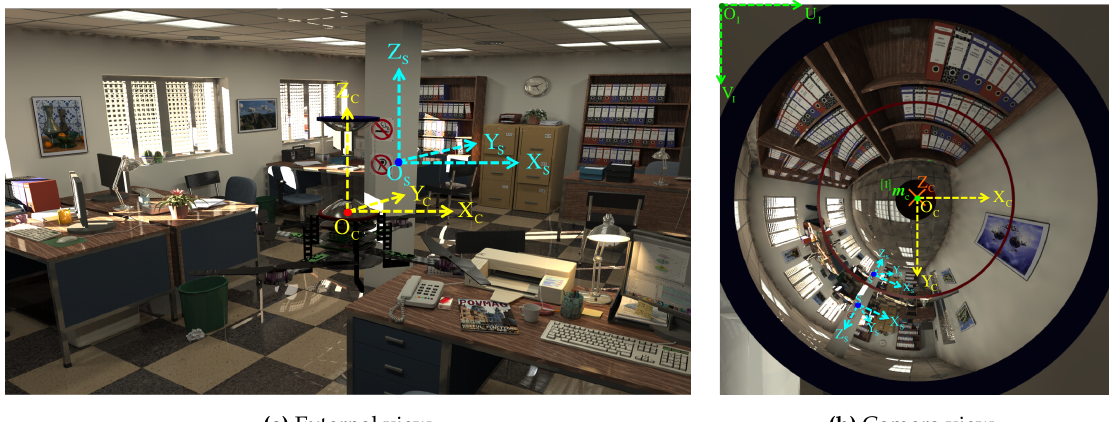
Figure 2. Photo-realistic synthetic scene: ( a ) Side-view of the quadrotor with the omnistereo rig in an office environment; ( b ) the image captured by the system’s camera using this